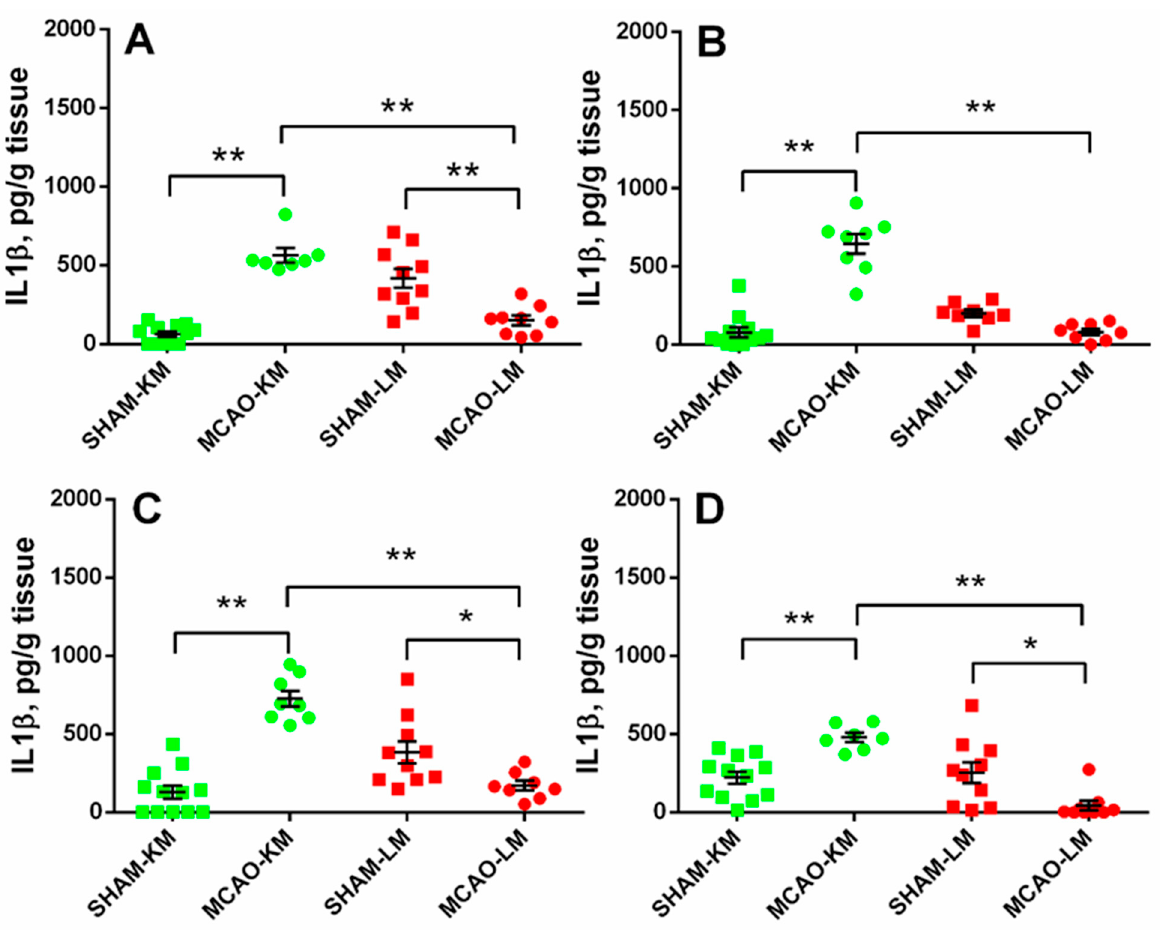
Figure 4. IL1 β levels in the hippocampus ( A , B ) and FC ( C , D ) of MCAO-KM and MCAO-LM groups 3 months after surgery. ( A ) Ipsilateral hippocampus. ( B ) Contralateral hippocampus. ( C ) Ipsilateral FC. ( D ) Contralateral FC. ( A – D ) IL1 β , pg/g tissue. ** p < 0.01 and * p < 0.05 compared with the respective sham-operated groups or MCAO-KM and MCAO-LM.